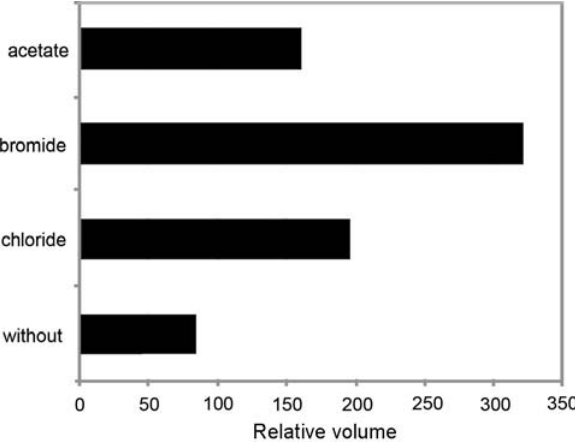
Figure 4. Relative volumes of the H-5’-H-b NOESY cross-peak in 1 in the absence and in the presence of different anions. NOESY 200 ms) were acquired in acetonitrile-d spectra ( π m cross-peak between triazole H-5’ and methylene H-a protons of 1 in the absence of anions was used as a reference, which was arbitra- rily set to 100